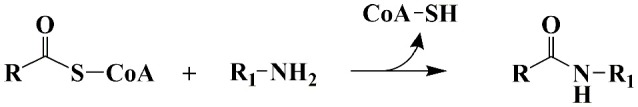
The reaction catalyzed by an arylalkylamine N-acyltransferase.